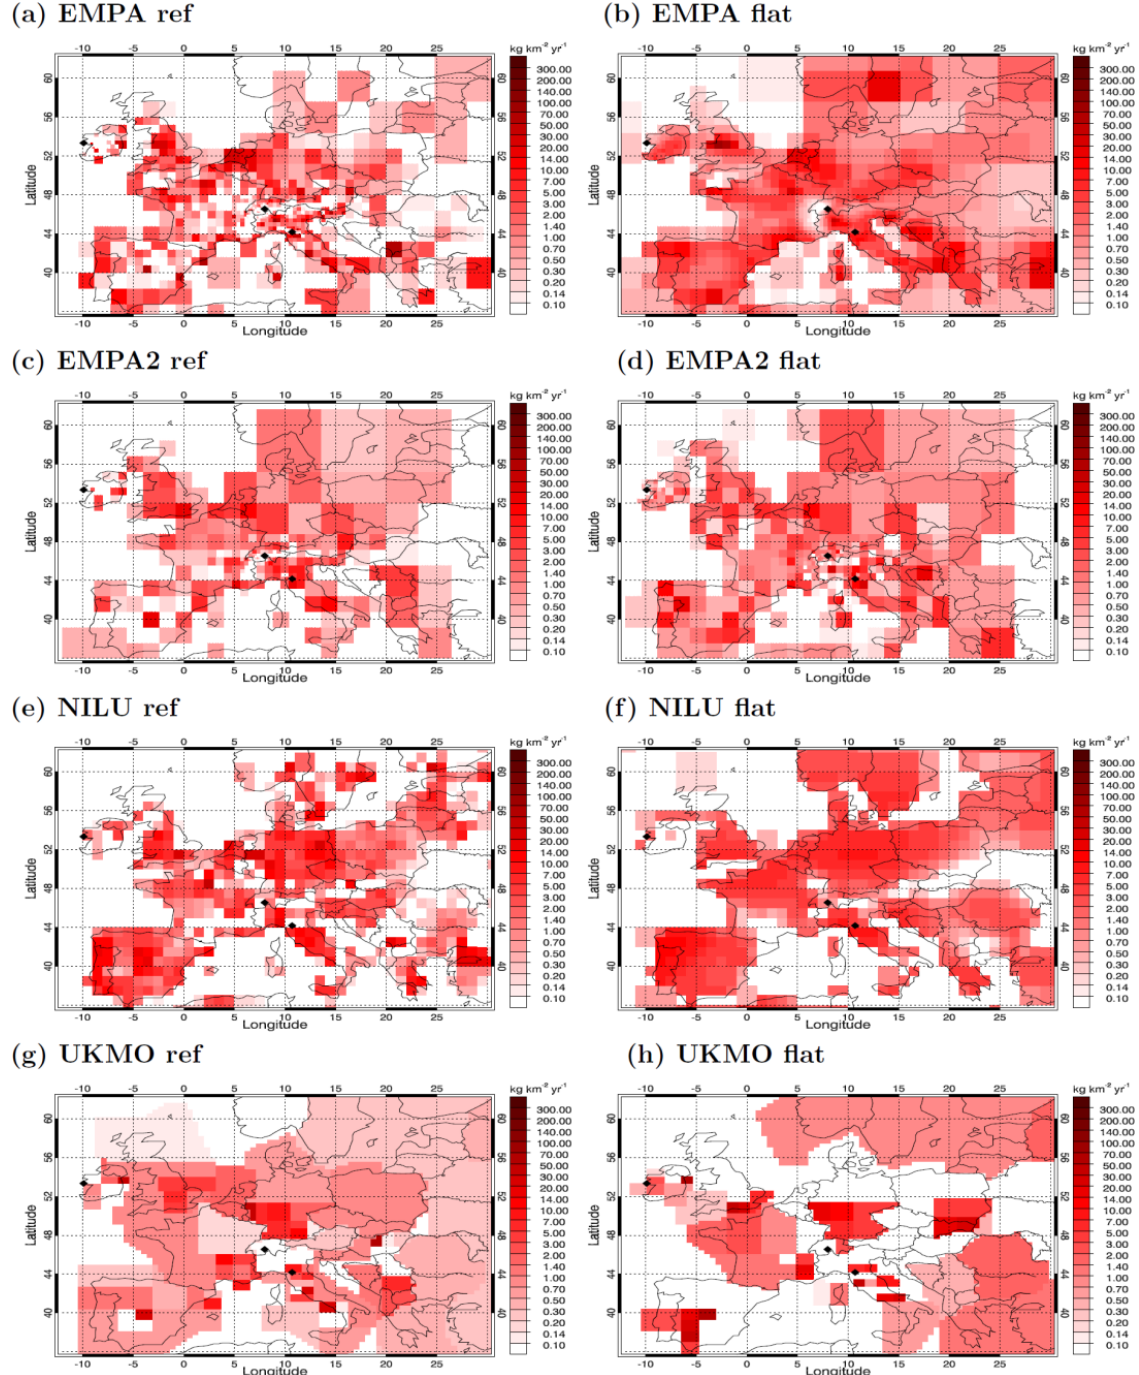
Figure 14. Posterior emissions of HFC-125 for the reference experiment M1 (a, c) and the experiment with flat prior (b, d) .